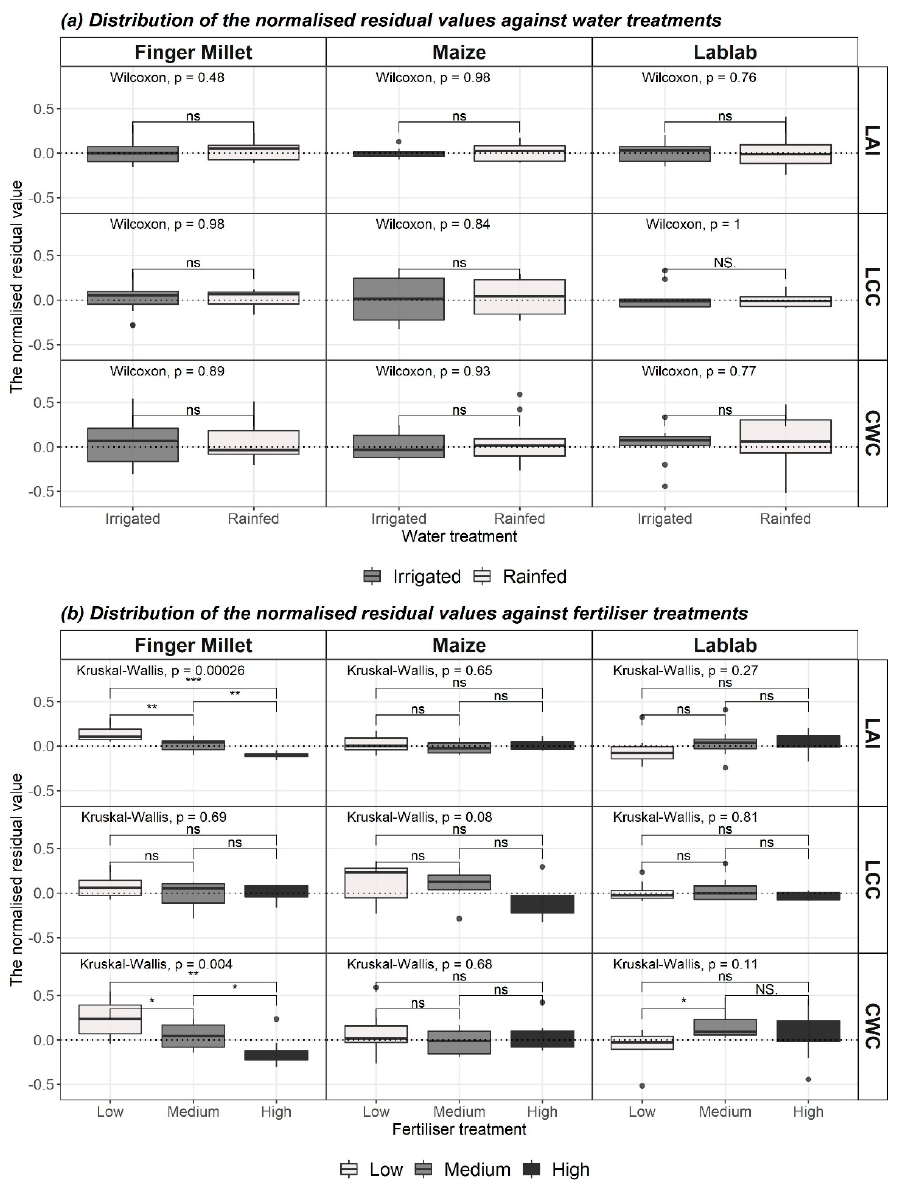
Figure A3. Distribution of the normalised residuals values against ( a ) water treatments and ( b ) fertiliser treatments from the best models for leaf area index (LAI) estimation, leaf chlorophyll content (LCC) estimation, and canopy water content (CWC) estimation for finger millet, lablab, and maize. The dashed line at y = 0 represents zero normalised residual value. (ns or NS: not significant, *: p < 0.05, **: p < 0.01, ***: p < 0.001).